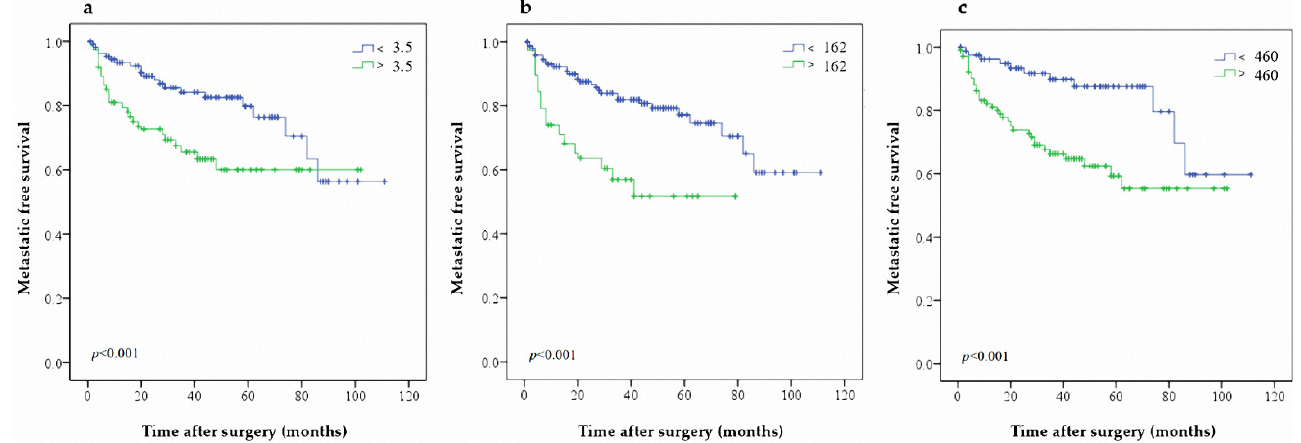
Figure 1. Predictive value of ( a ) NLR ( b ) PLR and ( c ) SII on MFS in patients with UTUC after RNU.